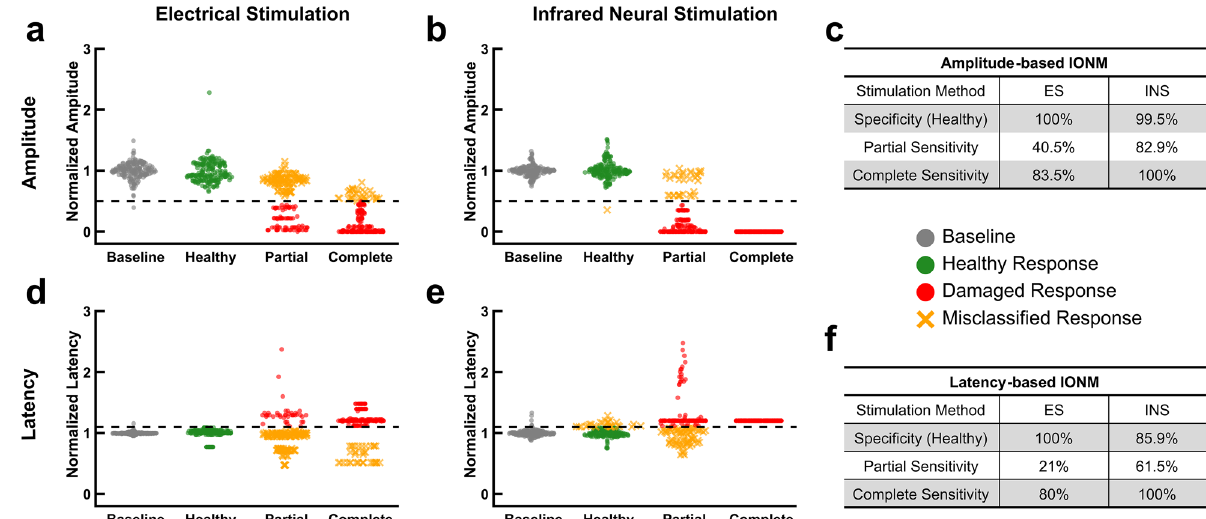
Figure 2. Infrared neural stimulation more readily detects crush injuries. ( a ) Normalized CMAP amplitudes resulting from ES in baseline, healthy, partially crush, and complete crush conditions. Black dashed line represents the amplitude damage threshold (50% decrease). ( b ) Normalized CMAP amplitudes resulting from INS in baseline, healthy, partially crush, and complete crush conditions. ( c ) Sensitivity and specificity for the amplitude-based IONM approach to crush injuries. ( d ) Normalized CMAP latencies resulting from ES in baseline, healthy, partial crush, and complete crush conditions. Black dashed line represents the latency damage threshold (10% increase). If no CMAP was evoked latency was set to 1.2 for ease of visual interpretation. ( e ) Normalized CMAP latencies resulting from INS in baseline, healthy, partial crush, and complete crush conditions. ( f ) Sensitivity and specificity for the latency-based IONM approach to crush injuries. Specificity in all cases was calculated using the ‘Healthy’ category of responses. All data is normalized to the mean baseline values for each individual nerve. n = 10 nerves for all data sets (5